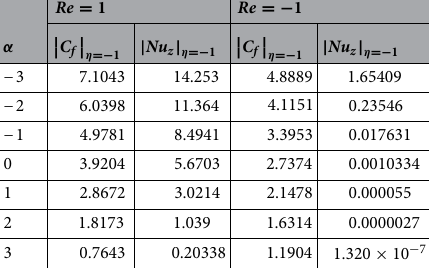
Table 7. Variation in C f and Nu z against α for ( HN fd ) (Cu– TiO 2 / water) when ϕ 1 = ϕ 2 = 0.01 , M = 1, Sc = 1, Pr =